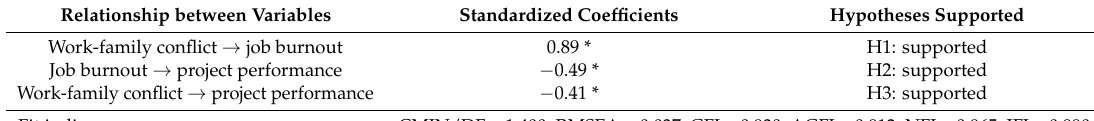
Table 6. The SEM results of theoretical